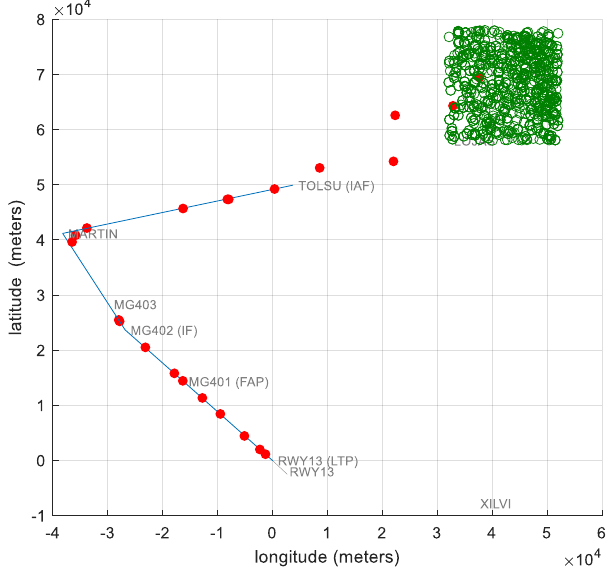
Figure 6. A set of simulated aircraft approaching the Málaga Airport (upper view).